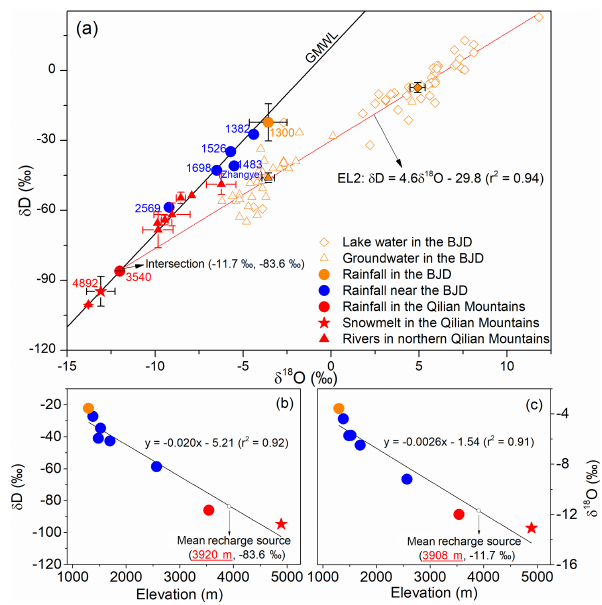
Figure 2. δ D vs. δ 18 O plot of water related to the BJD ground- water origin (a) , and altitude gradients of related precipitation iso- topes (b, c) . For precipitation (rainfall and snowmelt), the corre- sponding sampling elevations (ma.s.l.) are also shown. Statistical mean values are shown together with standard errors where feasi- ble. The weighted means of local rainfall (blue circles) are from Wu et al. (2010) and the GNIP database. Rainfall (yellow circle), lake water (yellow rhombus; 47 samples) and groundwater (yellow tri- angle; 31 samples) within the BJD area are based on data from Wu et al. (2017), Ma and Edmunds (2006), Zhao et al. (2012), Gates et al. (2008), Chen et al. (2012) and Yang et al. (2010). Summer rain- fall (red circle; 4 samples) and snowmelt (red pentagram; 15 sam- ples) in the Qilian Mountains are based on data from Ren (1999). Isotopic data for various rivers (red triangles) on the northern slope of the Qilian Mountain are collected from Chen et al. (2012), Li et al. (2016), Zhu et al. (2008) and Ren